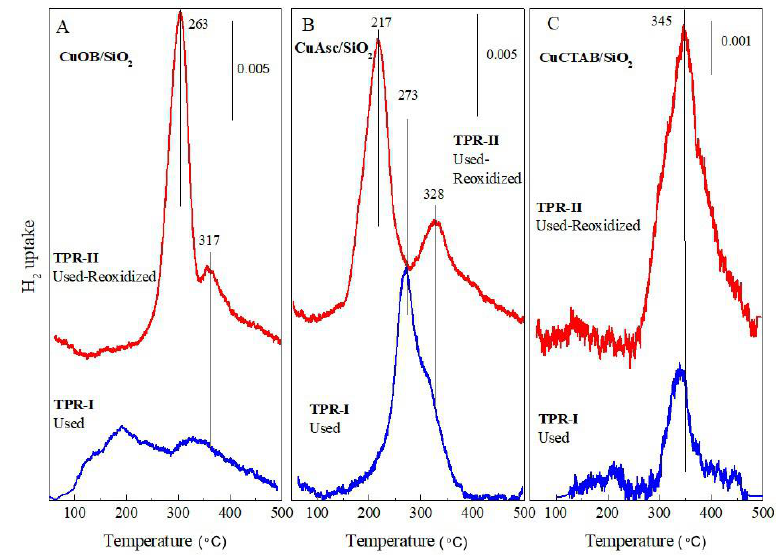
Figure 6. TPR profiles of the used (TPR-I) and re-oxidized catalysts after TPR-I (TPR-II). ( A ) CuOB / SiO 2 , ( B ) CuAsc / SiO 2 , ( C ) CuCTAB / SiO 2 . Catalyst weight: 50 mg. Re-oxidation treatment: 500 ◦ C in air flow, heating rate: 10 ◦ C min − 1